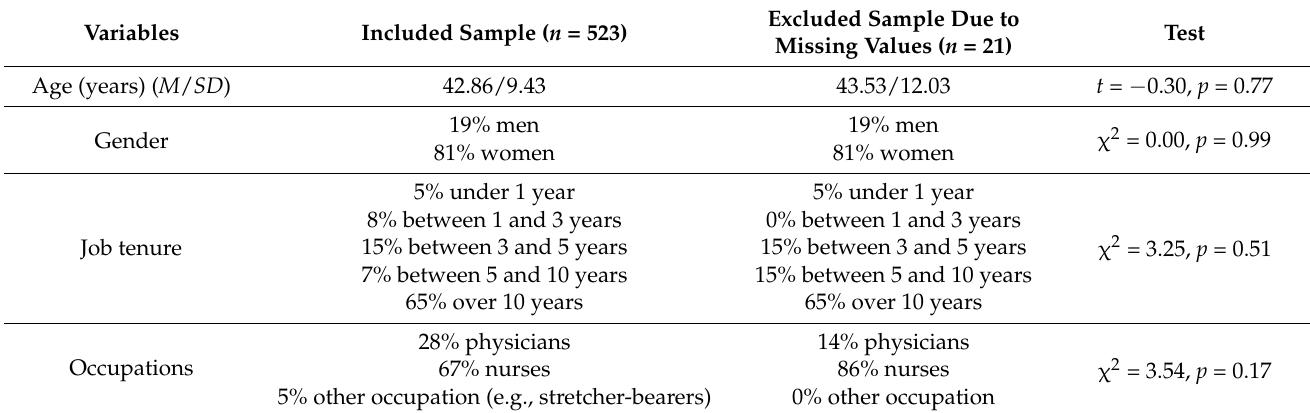
Table 1. Comparison between included and excluded